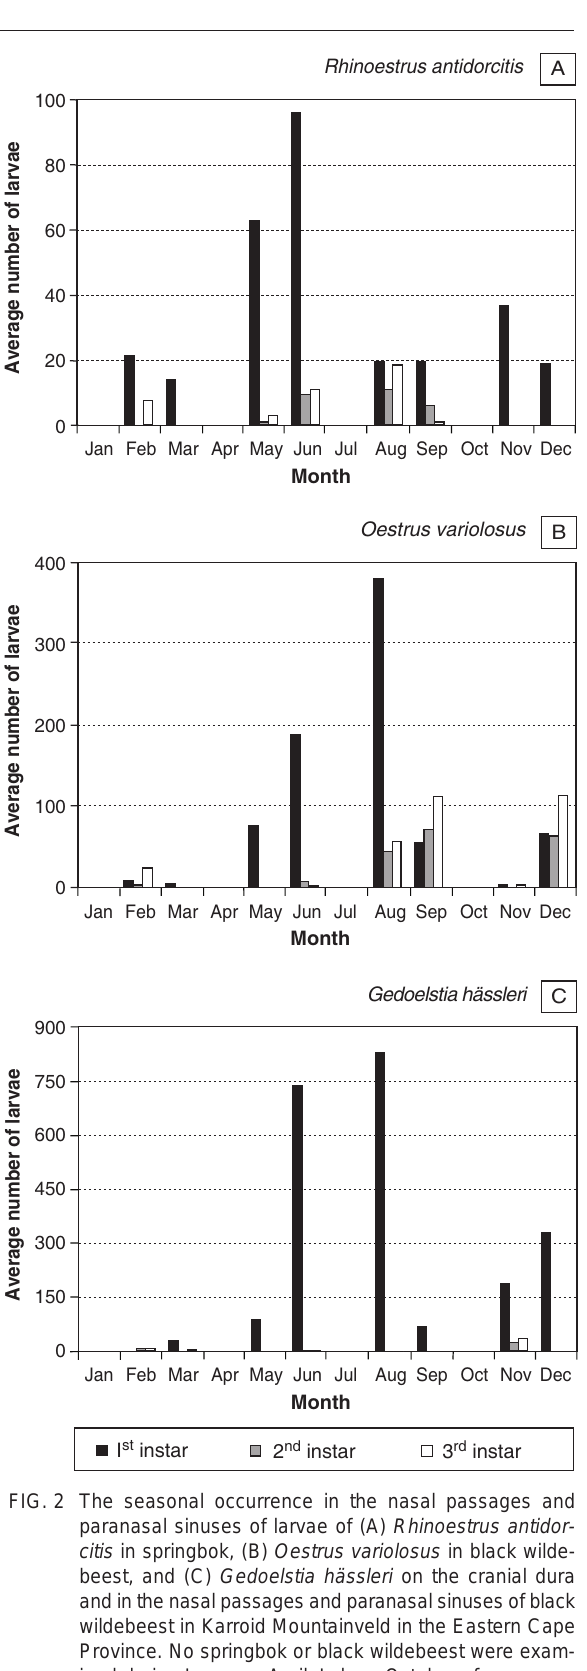
FIG. 2 The seasonal occurrence in the nasal passages and paranasal sinuses of larvae of (A) Rhinoestrus antidor- citis in springbok, (B) Oestrus variolosus in black wilde- beest, and (C) Gedoelstia hässleri on the cranial dura and in the nasal passages and paranasal sinuses of black wildebeest in Karroid Mountainveld in the Eastern